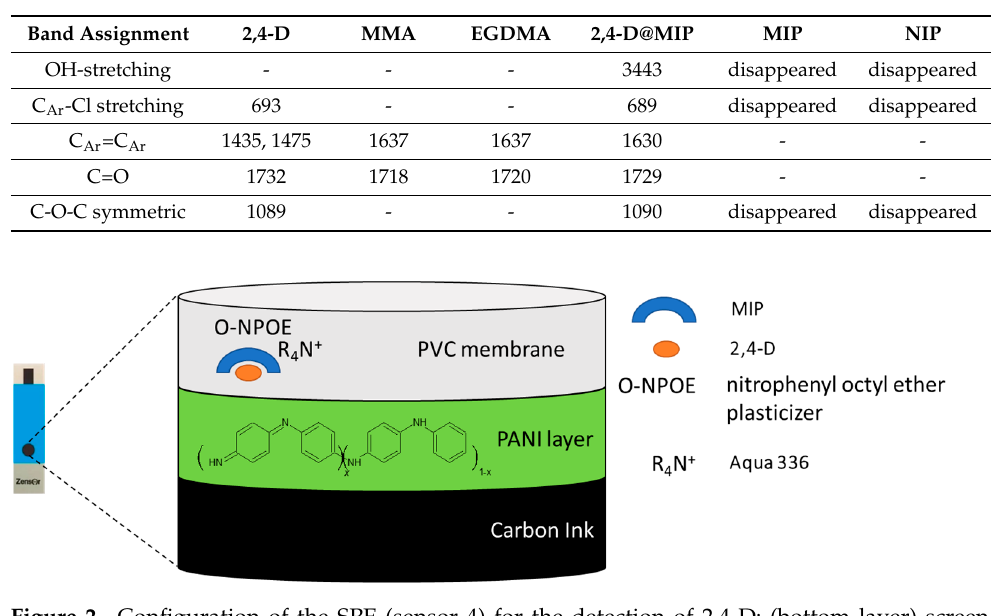
Table 1. FTIR band of 2,4-D, MAA, EGDMA, NIP, and MIP before and after washing.